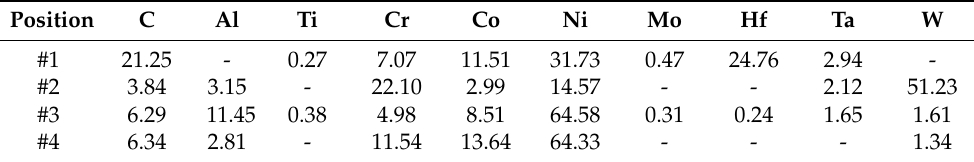
Table 2. SEM-EDS scan results according to Figure 3 (at.%).